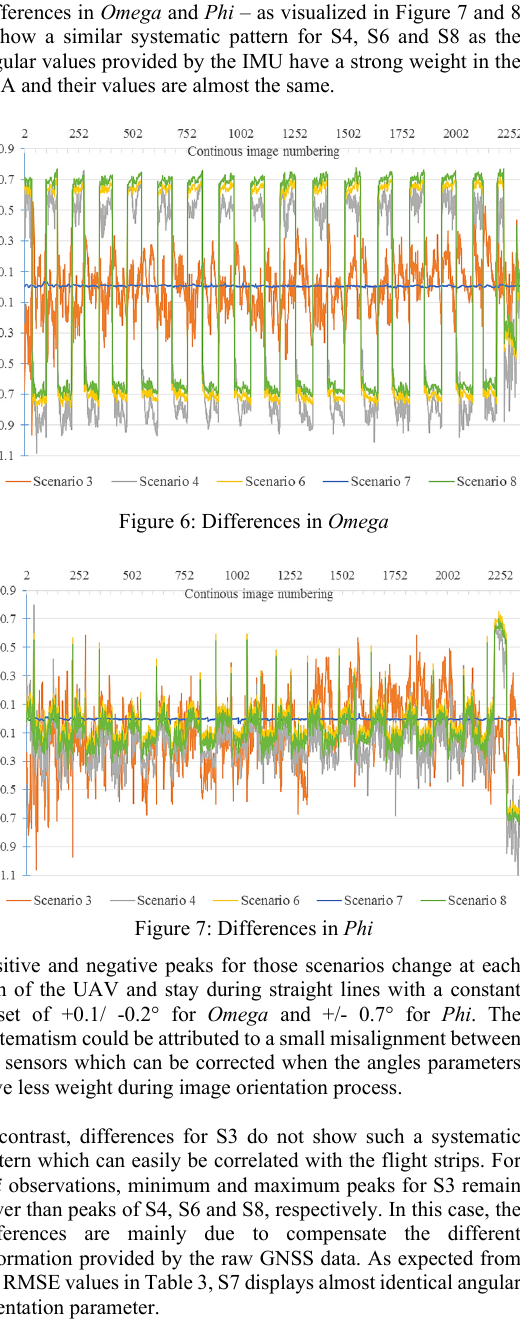
Table 5: Focal length (f) and mean reprojection error (R) of BBA S1 S2 S3 S4 S5 S6 S7